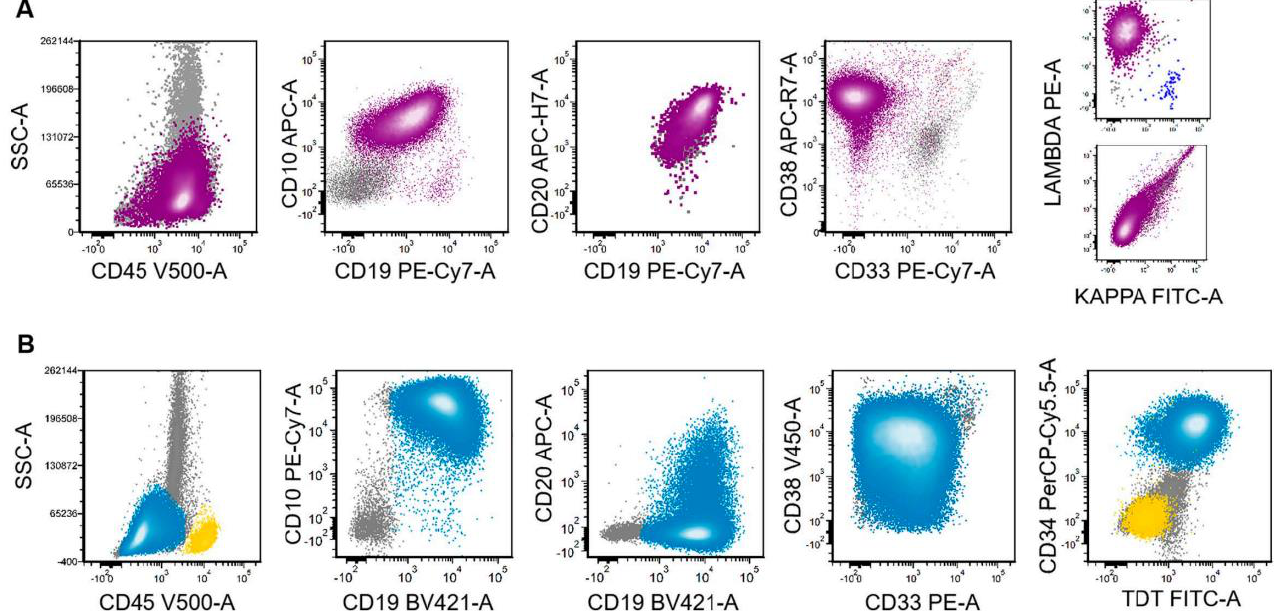
Figure 2. Comparison of immunophenotypic features in blastoid HGBL versus B-ALL by flow cy- tometric analysis. ( A ) A representative case of blastoid HGBL (magenta) showed brighter CD45, less bright CD10, relatively stronger CD20, and brighter CD38 with or without (small subset cases) surface light chains. ( B ) In contrast, the lymphoblasts (blue) of B-ALL showed the opposite expression patterns for these markers, in addition to the expression of myeloid antigens (CD33) and immature markers (CD34 and TdT). Yellow population indicates the normal lymphocytes and gray for granulocytes in the background. Table 1. Comparison of immunophenotyping between blastoid HGBL and B-ALL.